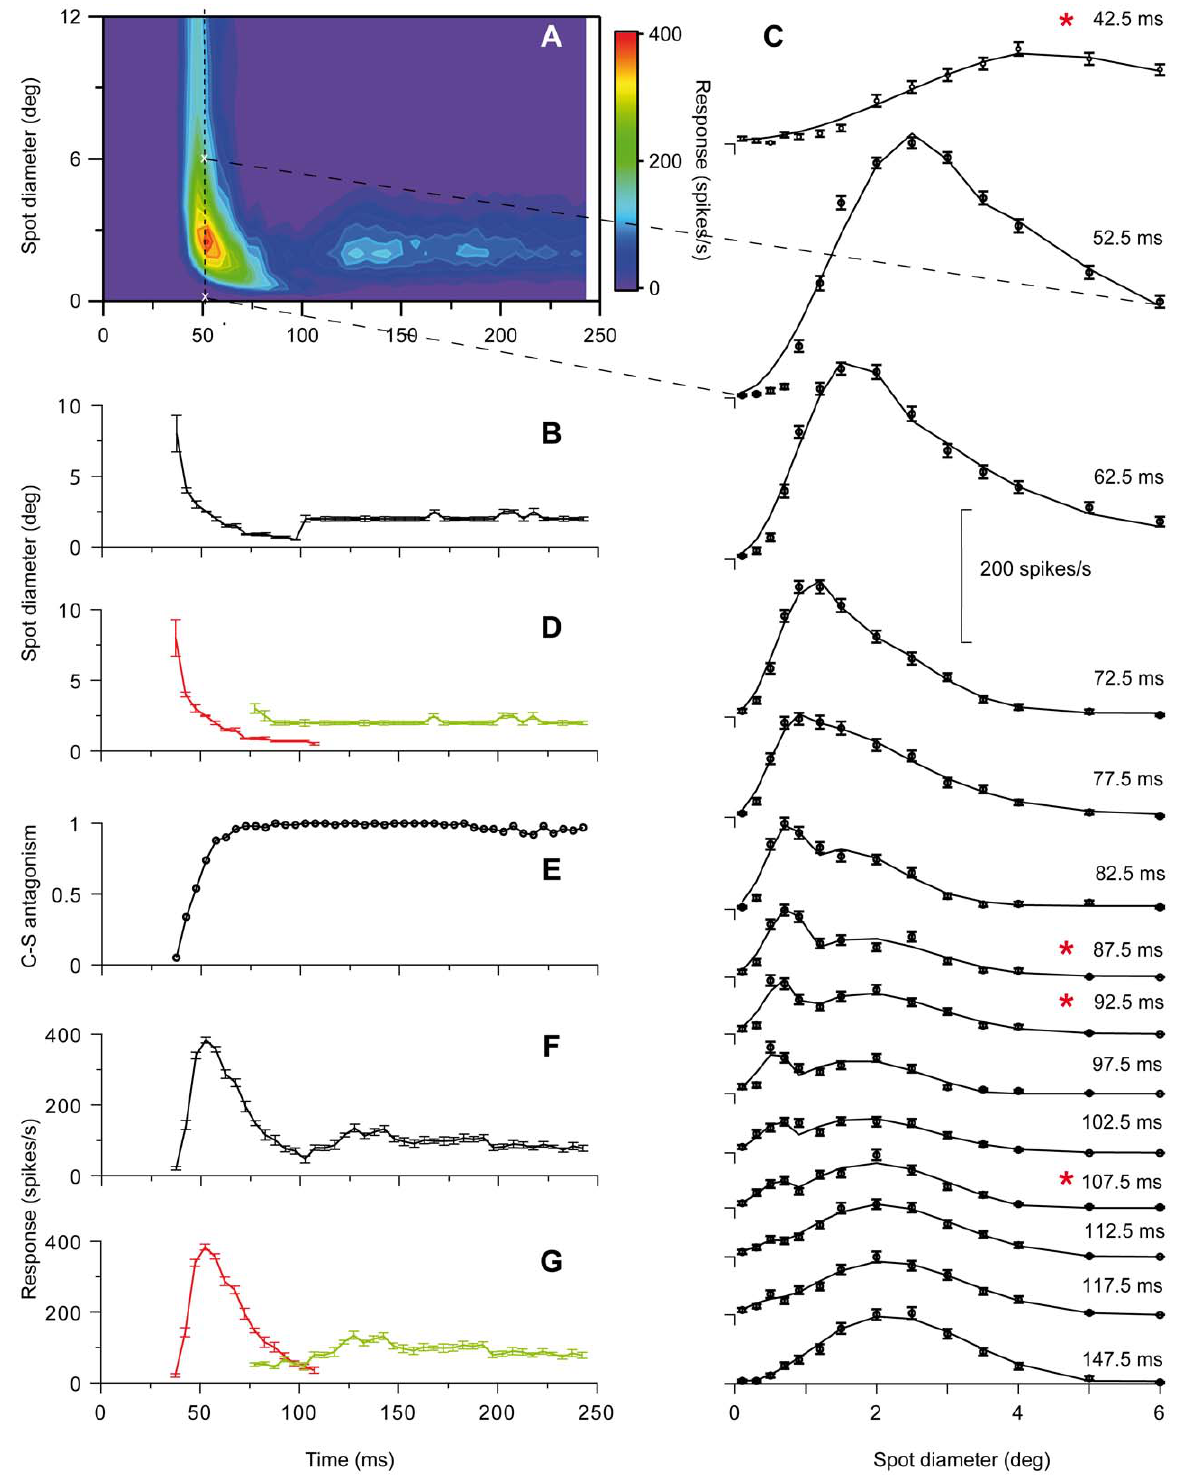
Figure 1. RF dynamically changes during brief stimulus presentation. Data from an on-center Y-neuron. A , Colormap image of response (z- axis) to a series of spots (n=25) of different diameters (y-axis) at different time after spot onset (x-axis). Spots were centered on the RF. B , Center- width as function of time after spot onset. Center-width was determined by spot diameter giving maximal response. The RF-center shrank from initially 8 deg to a minimum of 0.5 deg and then increased to a stable width of 2 deg at , 100 ms. C : Spot width tuning curves for a selected number of time-slices. Notice the truncated x-axis. The time-slice for the spatial summation curve at 52.5 ms is marked by the vertical dashed line in (A), and the first and last data point in this curve are marked by white crosses in (A). Notice the shoulder or bimodal appearance of the curves in the range of 72.5 and 107.5 ms. Single (Eq. 4) and double (Eq. 5) DOG-functions were fitted to the data. Continuous curves show the best-fitting 2-DOG function (linearly interpolated between the spot sizes corresponding to experimental data points). Cases in which the 2-DOG gave statistically better fit than